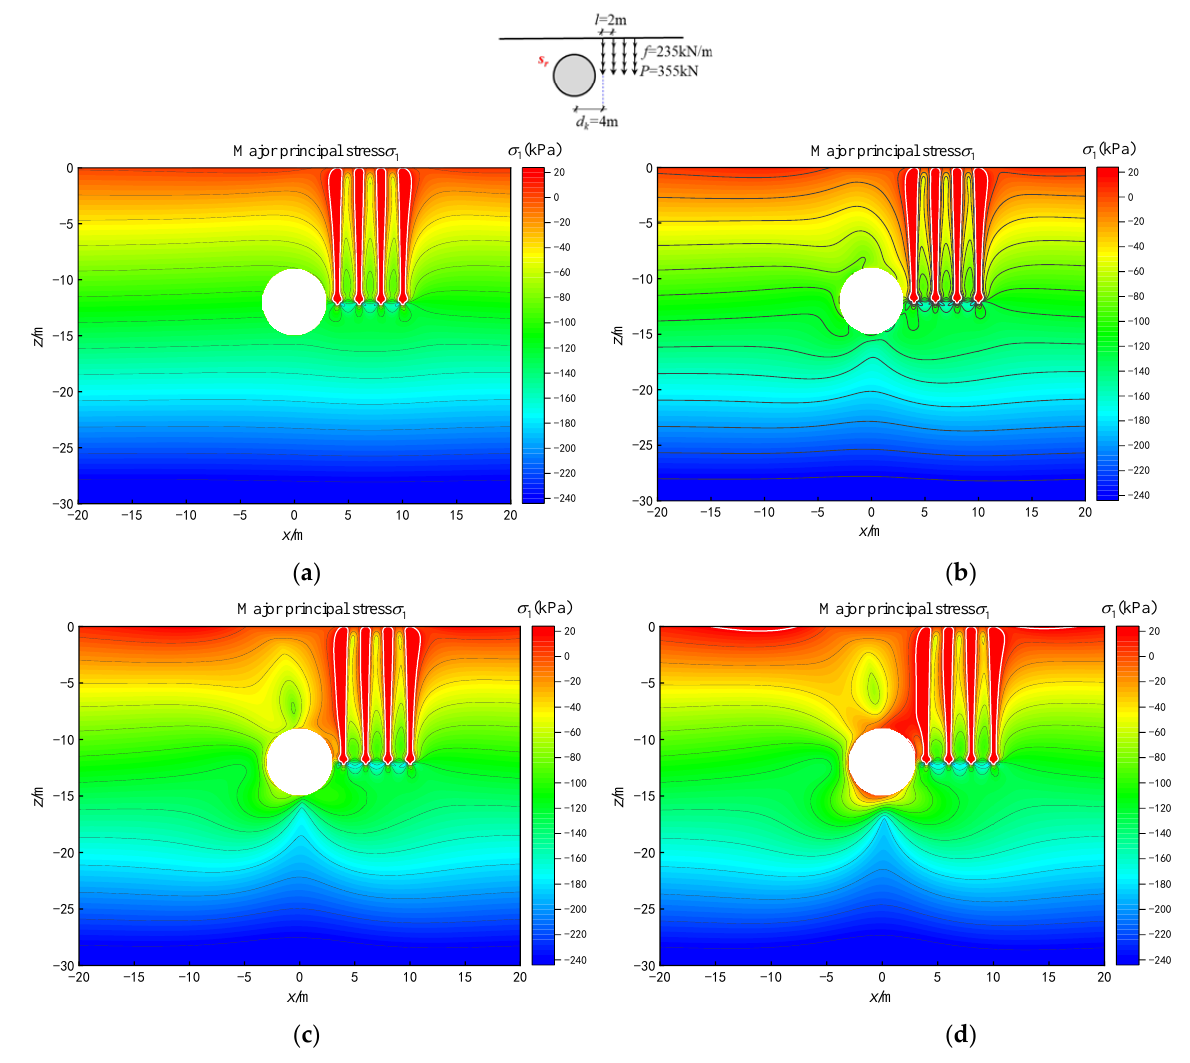
Figure 7. Contour diagrams of major principal stresses with various s r : ( a ) s r = 0; ( b ) s r = 0.3; ( c ) s r = 0.7; ( d ) s r = 1.